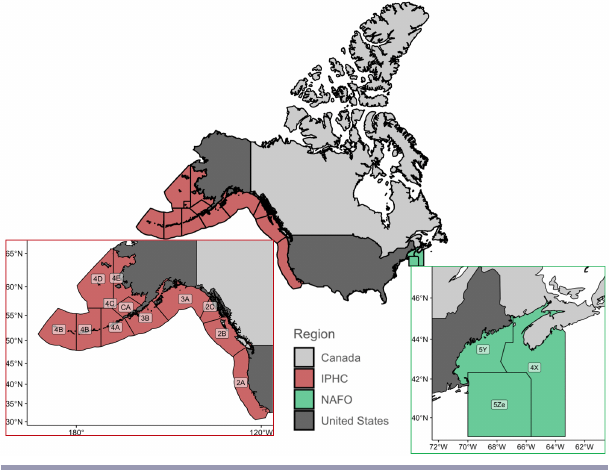
Fig. 1 . Map of North America with the regulatory areas of the International Pacific Halibut Commission (IPHC) and the Northwest Atlantic Fisheries Organization (NAFO) subregion related to the Gulf of Maine agreement. “CA” = closed